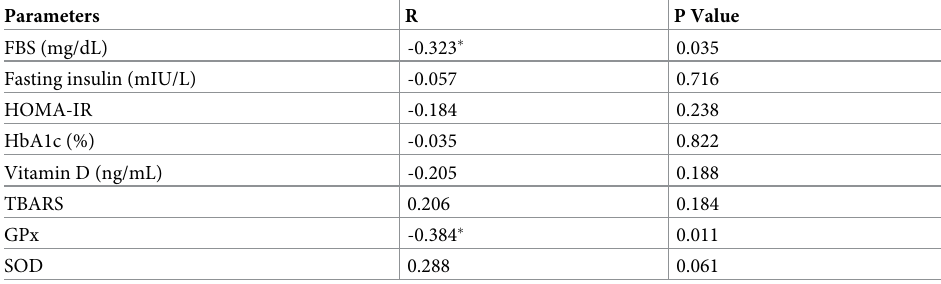
Table 8. Correlation between 3MS score and various biochemical parameters among non-diabetic subjects with vitamin D insufficiency.